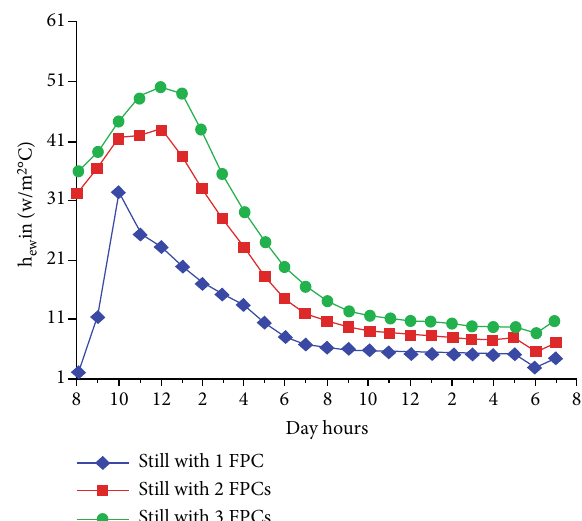
Figure 16: E ff ects of the number of the fl at plate collector on the evaporative heat transfer coe ffi cient